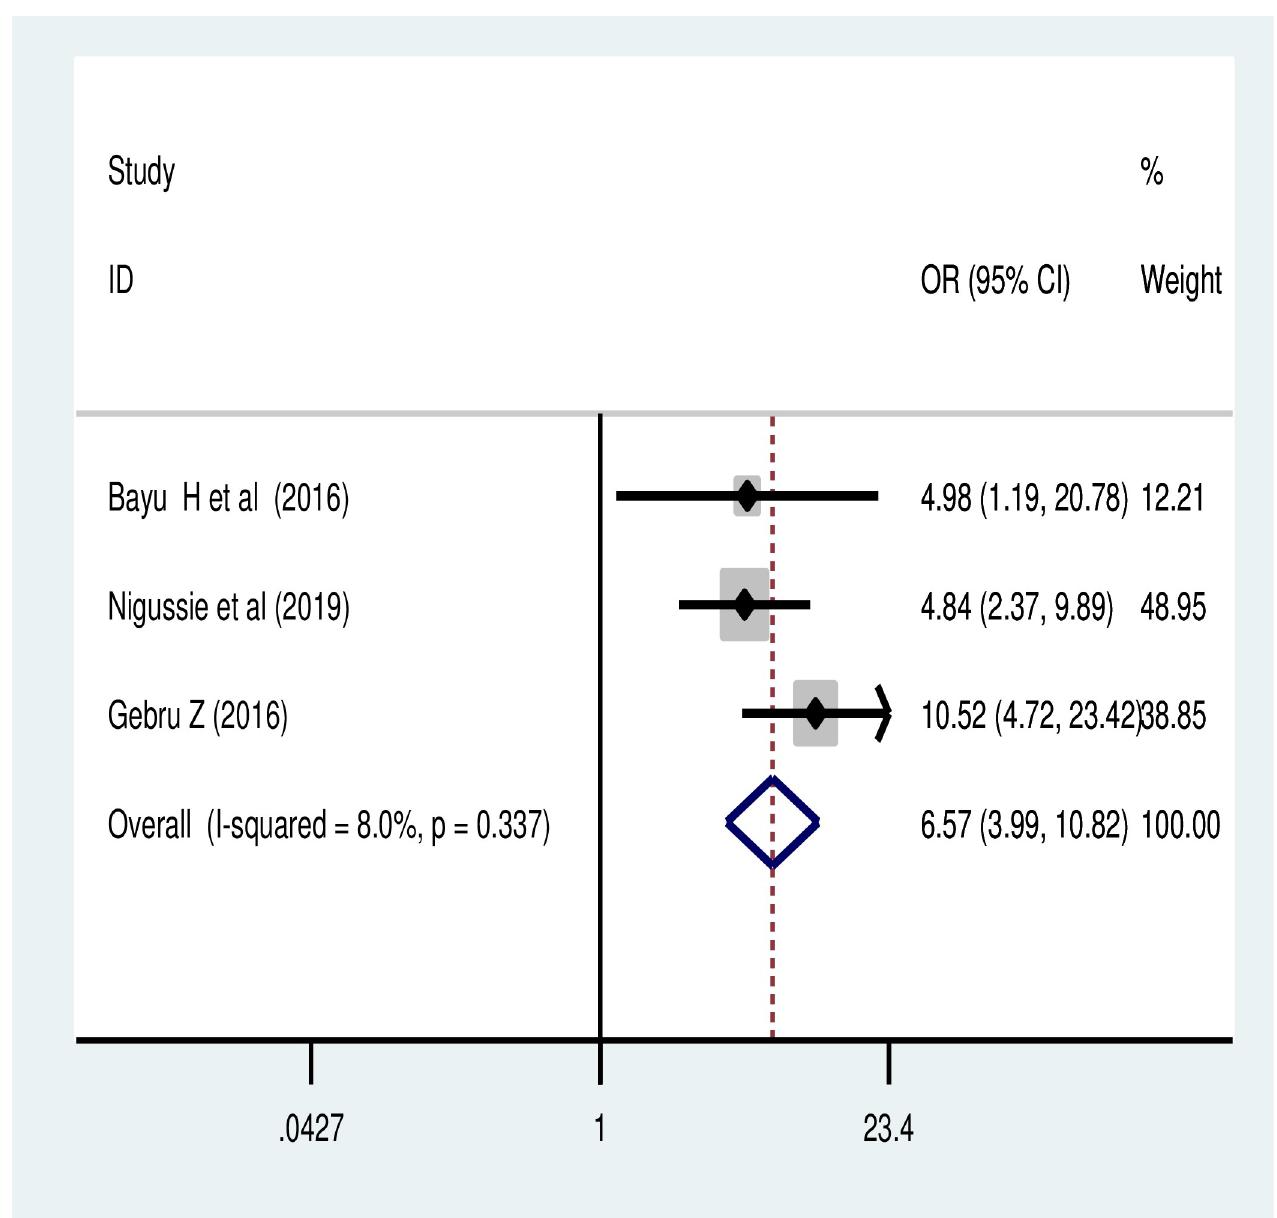
Fig 7. Association of perceived severity of cancer and cervical cancer screening